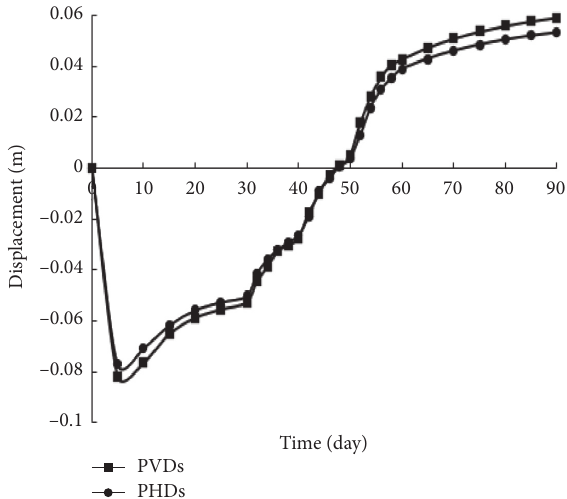
Figure 10: Relationship curve between horizontal displacement and